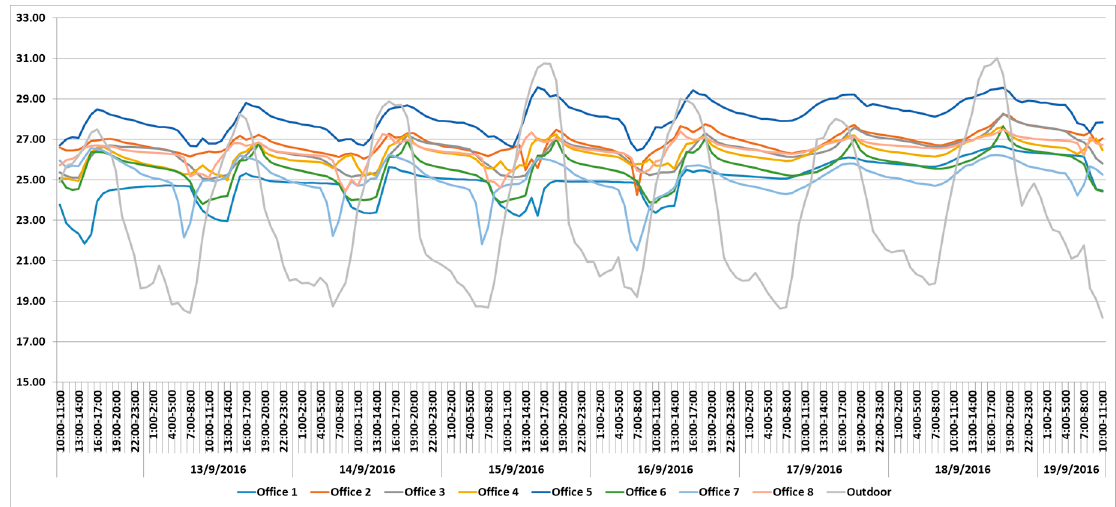
Figure 5. Temperature levels of the external and all the indoor environment of Building B during summer.